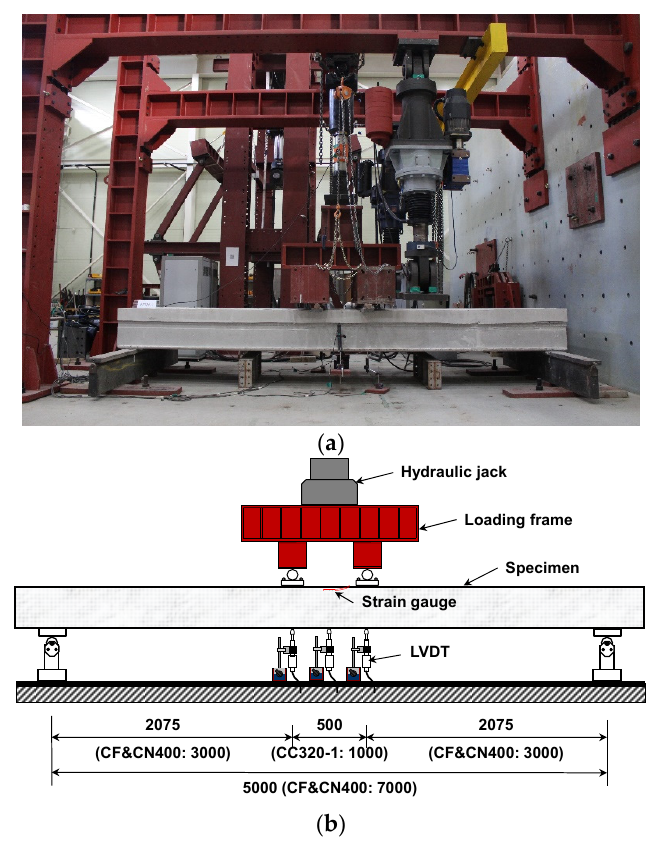
Figure 5. Test setup of specimen (unit: mm): ( a ) photograph; ( b ) elevation view.